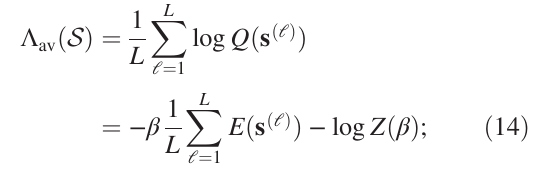
for 10 random av